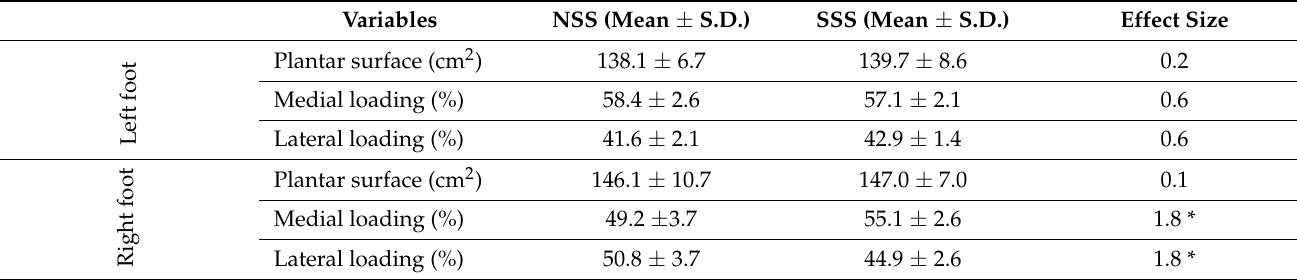
Table 3. Plantar pressure values for NSS and SSS between Left and Right foot.